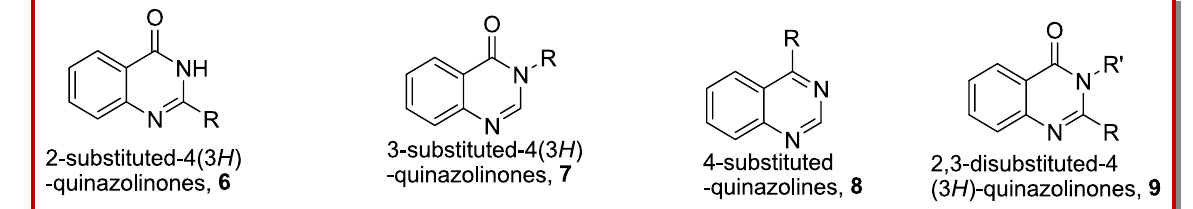
Figure 3: Classification of quinazoline and quinazolinone